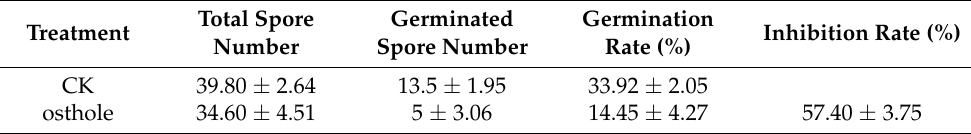
Figure 3. Effect of osthole on the morphology of F. oxysporum mycelia and spore germination. ( A ): CK, images of Fusarium oxysporum mycelia on PDA medium acquired using optical microscope; ( B ): images of Fusarium oxysporum mycelia on PDA medium plus 5 mg/mL osthole acquired using optical microscope. Mycelial morphology was observed by scanning electron microscopy and is shown in ( C ) (CK) and ( D ) (5 mg/mL osthole). ( E ): CK, Spore germination of Fusarium oxysporum on PDA liquid medium; ( F ): Spore germination of Fusarium oxysporum on PDA liquid medium plus 3 mg/mL osthole. Table 1. Germination of F. oxysporum